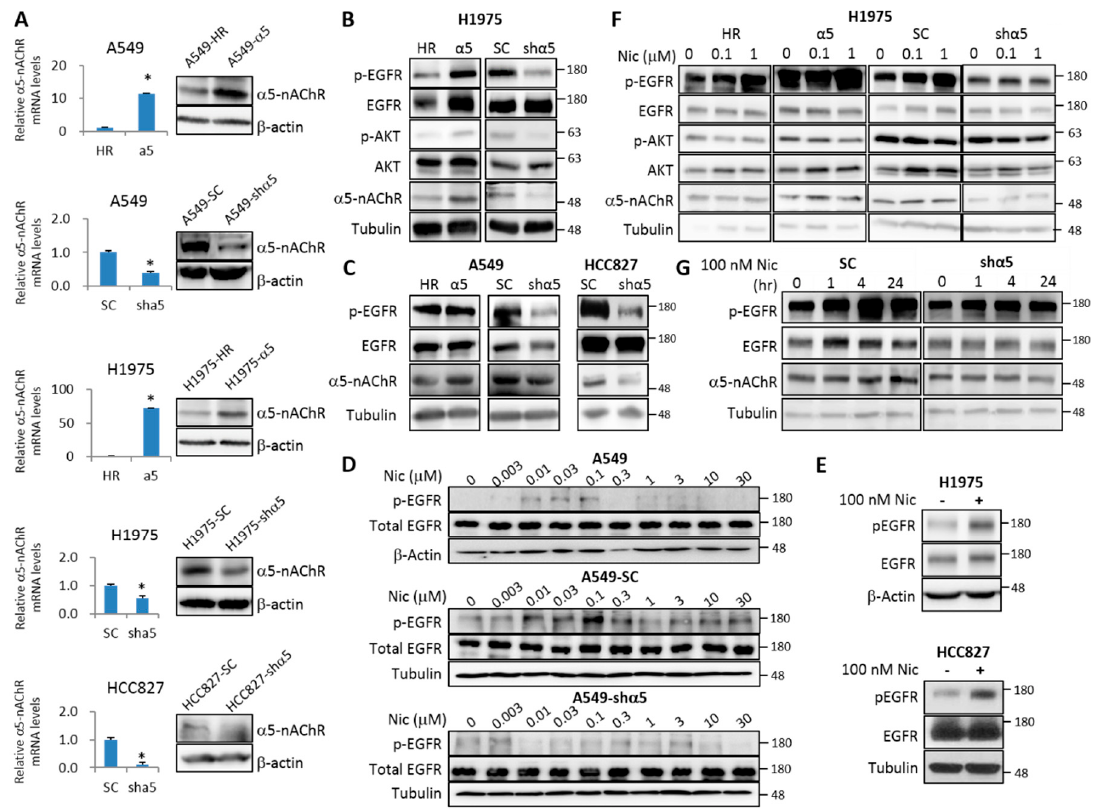
Figure 2. α 5-nAChR mediates nicotine-induced activation of EGFR signaling. ( A ) α 5-nAChR-overexpressing ( α 5) and knockdown (sh α 5) stable cells lines, and the respective empty vector (HR) and scrambled shRNA (SC) controls were established in A549, H1975, and HCC827 cell lines using a lentivirus transfection system. Cells were subjected to western blot analysis to assess the protein level of α 5-nAChR. ( B ) H1975 stable cell lines were subjected to western blot analysis to assess the levels of indicated proteins. ( C ) A549 and HCC827 stable cells were analyzed by western blot to assess the expression level and phosphorylation status of indicated proteins. ( D ) A549 parental and stable cell lines were serum deprived for 24 h before 1 h treatment with variable concentration of nicotine. The phosphorylation status of EGFR was analyzed by western blot. ( E ) H1975 and HCC827 cells were serum deprived for 24 h before 1 h treatment with 100 nM of nicotine. The levels of total and phosphorylated EGFR were analyzed by western blot. ( F ) H1975 stable clones were serum-deprived for 24 h and subsequently treated with different doses of nicotine for another 24 h. Total cell lysates were subjected to western blot analysis. ( G ) H1975 stable clones were serum-deprived for 24 h before nicotine treatment. Total cell lysates were collected at 1, 4, and 24 h after the addition of 100 nM nicotine and analyzed by western blot. All data were repeated in at least three independent experiments to achieve statistical significance. Statistical analysis was performed using unpaired Student’s t test. * p < 0.05. The numbers at the right-hand side of the western blots indicates the sizes of the nearest protein markers.